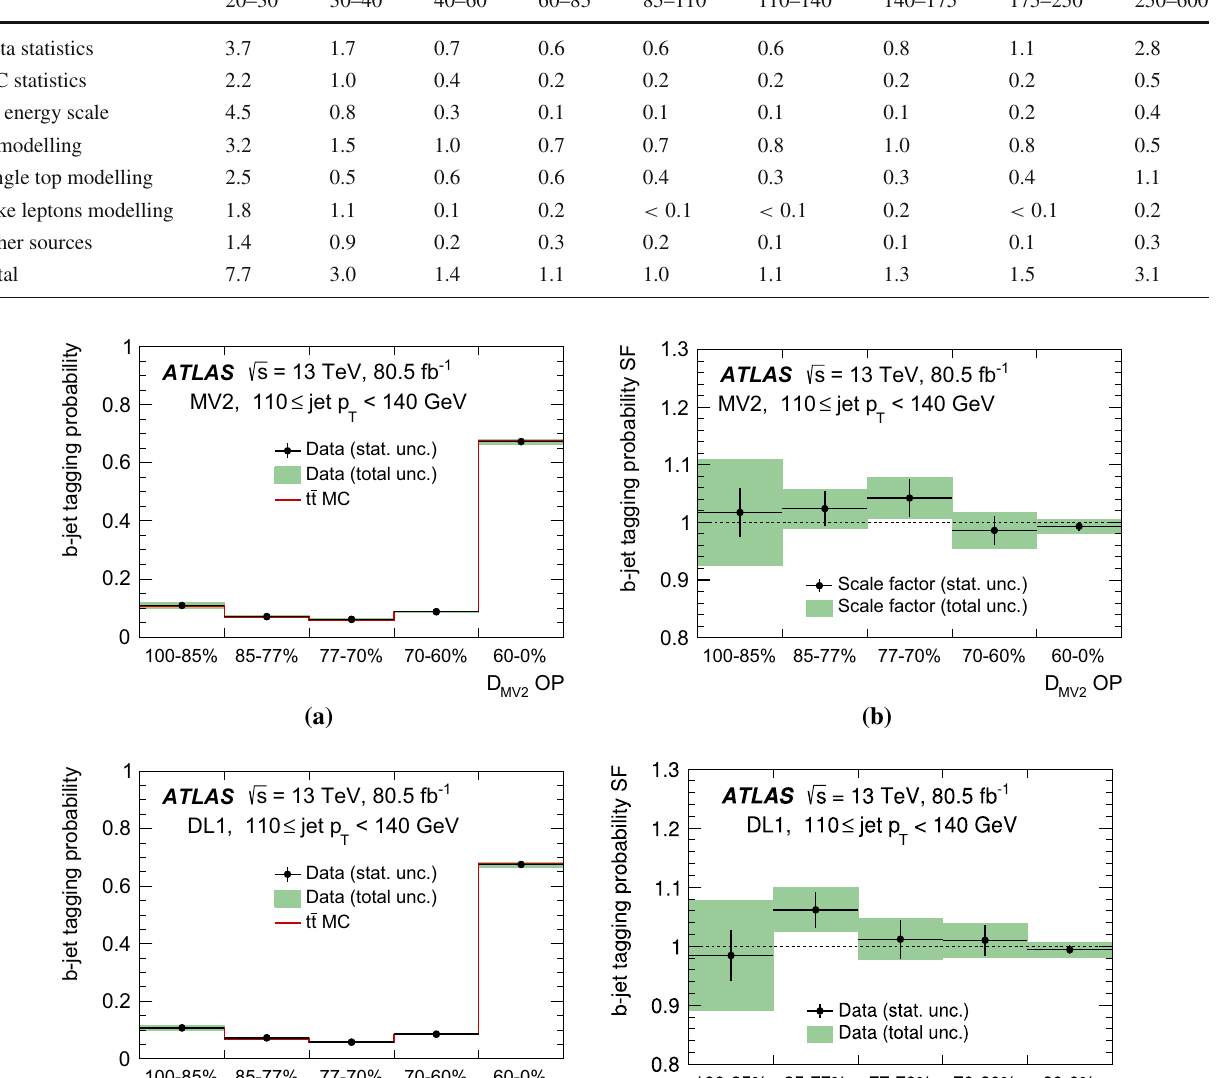
ing the signal region selection. Vertical error bars include data statis- tical uncertainties only while the green bands correspond to the sum in quadrature of statistical and systematic uncertainties. The dots are located at the bin